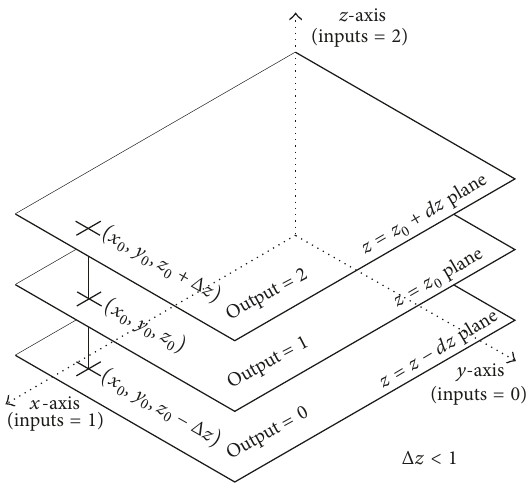
Figure 7: Ternary logic representation ( 𝑥 0 ,𝑦 0 , 𝑧 0 ∈ N ). The point (𝑥 ,𝑦 , 𝑧 ±Δ𝑧 or 𝑧 ) represents the input condition, where all inputs 0 0 0 0 corresponding to 𝑥 -coordinate = 1, all inputs corresponding to 𝑦 - coordinate = 0, and all inputs corresponding to 𝑧 -coordinate = 2.